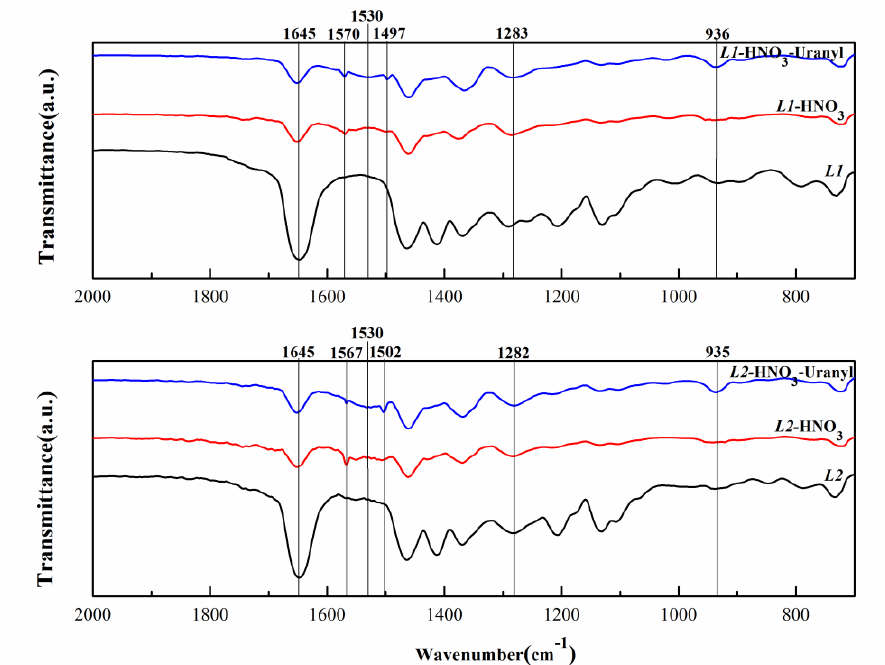
Figure 6. Infrared spectra of organic phases: solutions of L , solutions contacted with nitric acid ([HNO 3 ] ini = 3 mol/L), and U(VI) aqueous solutions with nitric acid ([HNO 3 ] ini = 3 mol/L).